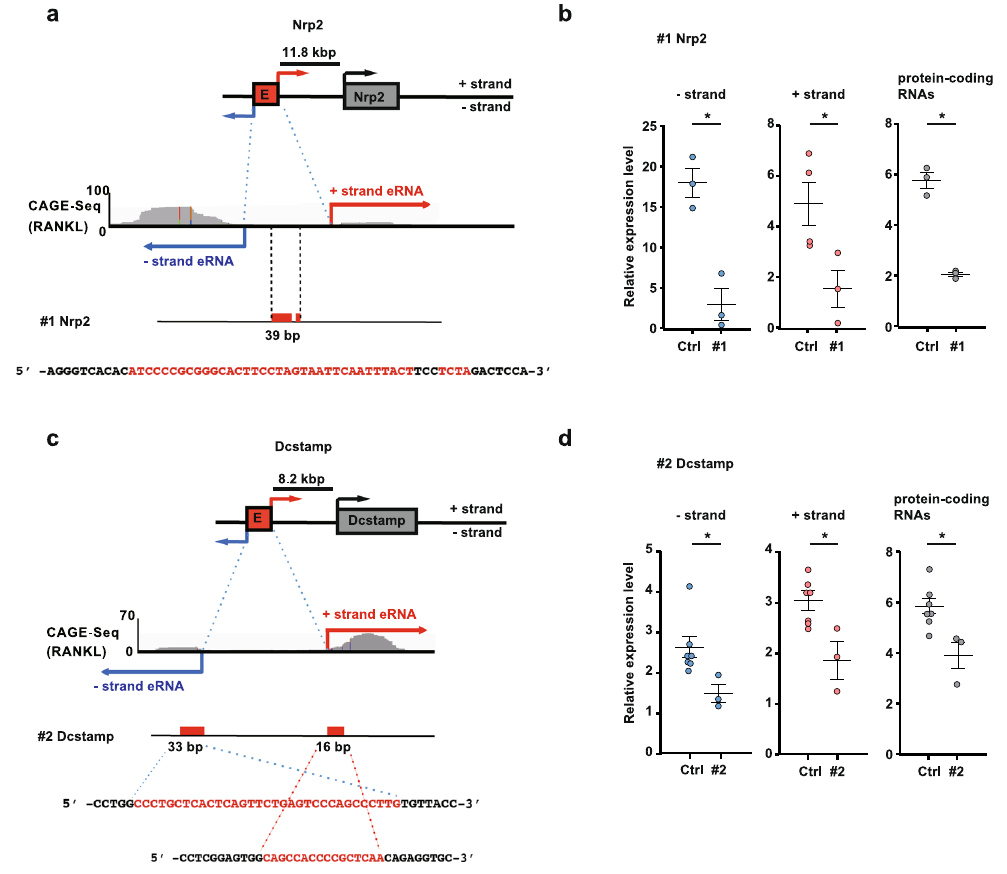
Figure 3. The effect of deletions in the 5 ′ putative eRNA regions of Nrp2 and Dcstamp using CRISPR/ Cas9. ( a , c ) Schematic diagram of the genomic loci with the CAGE profile and the deleted regions (deletions are marked with red letters) in RAW 264.7 cells. (b , d ) qRT-PCR analysis of the relative expression levels of protein-coding RNAs as well as the putative − and + strand eRNAs following RANKL stimulation of the #1 Nrp2 putative eRNA region-deletion mutant and the targeted deletion of the #2 Dcstamp mutant. Control cells (Ctrl) were transfected with the scrambled sequence shown in Supplementary Table S3. Data denote the mean ± SEM from independent biological replicates; #1 Nrp2 (n = 3), Ctrl (Nrp2, n = 3–4), #2 Dcstamp (n = 3), Ctrl (Dcstamp, n = 7) with 3–4 technical replicates each. Analyses were performed on total RNAs. * P < 0.05 [Student’s t -test for ( b ); Dunnett’s test for ( d ) to evaluate with other clone, #3 and 4. The results of #3 and 4 are shown in Supplementary Figure